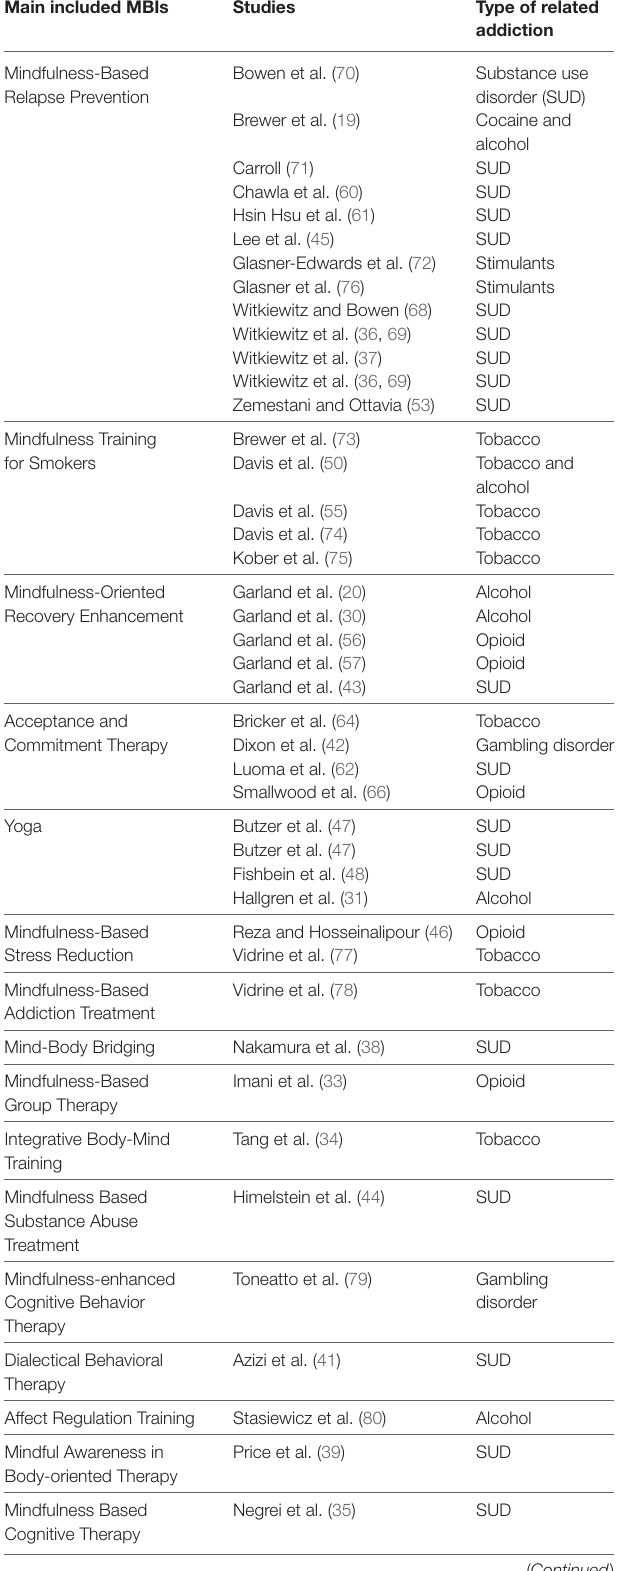
taBLe 1 | Relation of the main included mindfulness-based interventions (MBIs) in the search literature and the type of related